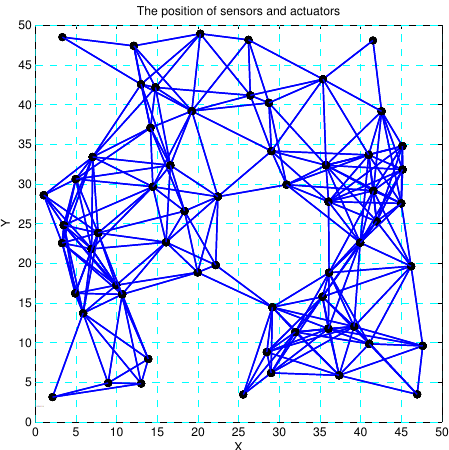
Figure 8. 60 sensors randomly deployed in 50 × 50 region.